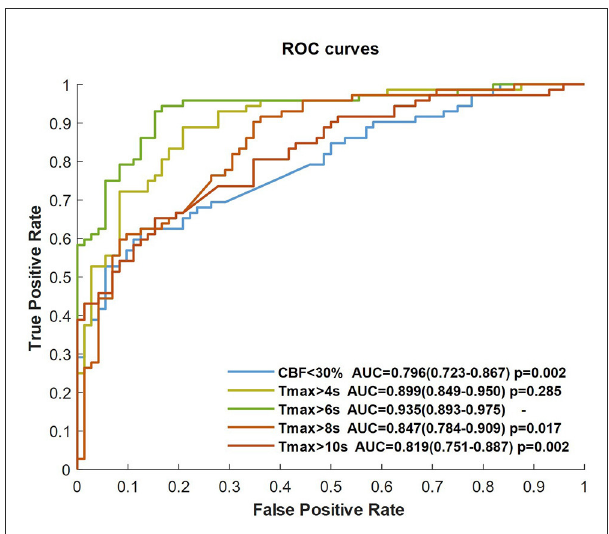
FIGURE3 ROC curves of the CNN trained by CBF, Tmax, and each ROI mask.